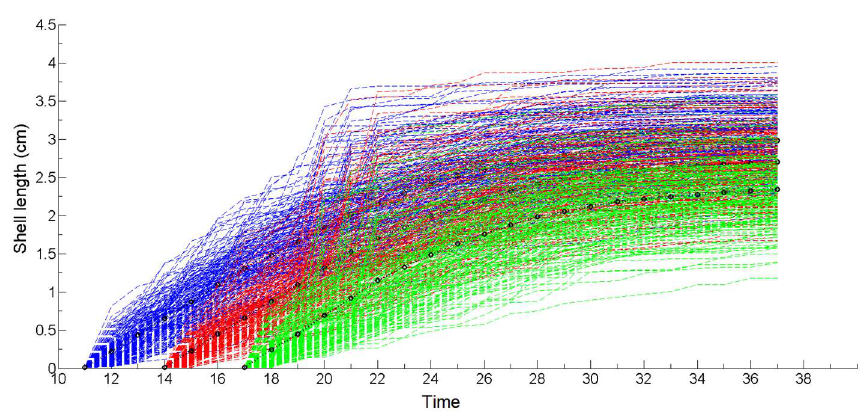
Figure 11. Simulated individual shell length of blue mussels for the 2nd typical macro-colonization (11-12-17). 200 simulations are presented.